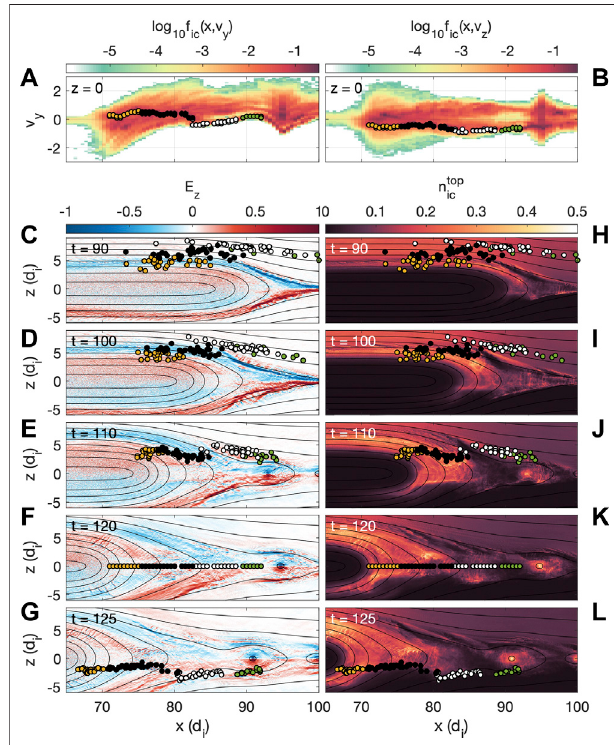
FIGURE 5 | Test particle positions at fi ve different times. The initial conditions for each particle are taken at t (cid:1) 120, from the locations in phase space shown in (A, B) . (C – G) , and ( H – L) shows the particle position for fi ve different times, overlaid E z and n top ic , respectively. The subdivision into yellow/black/white/green populations are partly based on the initial conditions, and further explained in the